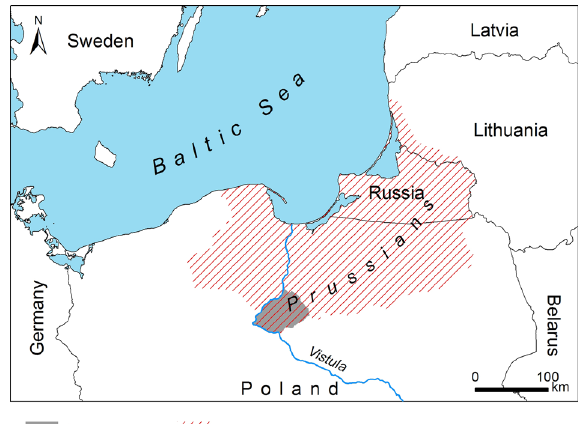
Fig. 1. Location of the research area in the background territory of the State of the Teutonic Order in the 14th century based on Czaja